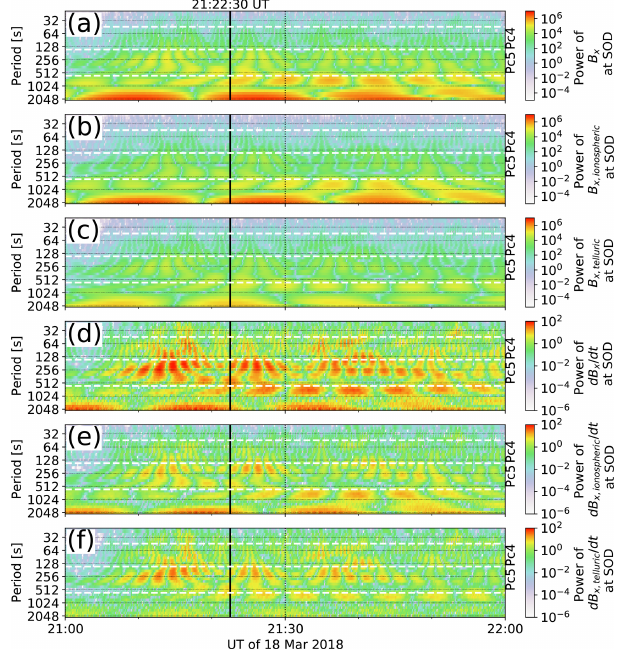
Figure 5. Wavelet transform of the magnetic field north compo- nent B x at SOD, as a function of UT for the event in Fig. 2 (a) . The same transform applied to the primary ionospheric (b) and sec- ondary telluric B x (c) and their time derivatives (d–e) . The black vertical line indicates the time shown in Fig. 2. The period ranges of the ultra-low frequency (ULF) pulsation classes Pc4 (45–150s) and Pc5 (150–600s; Jacobs et al., 1964) are shown with the white horizontal dashed